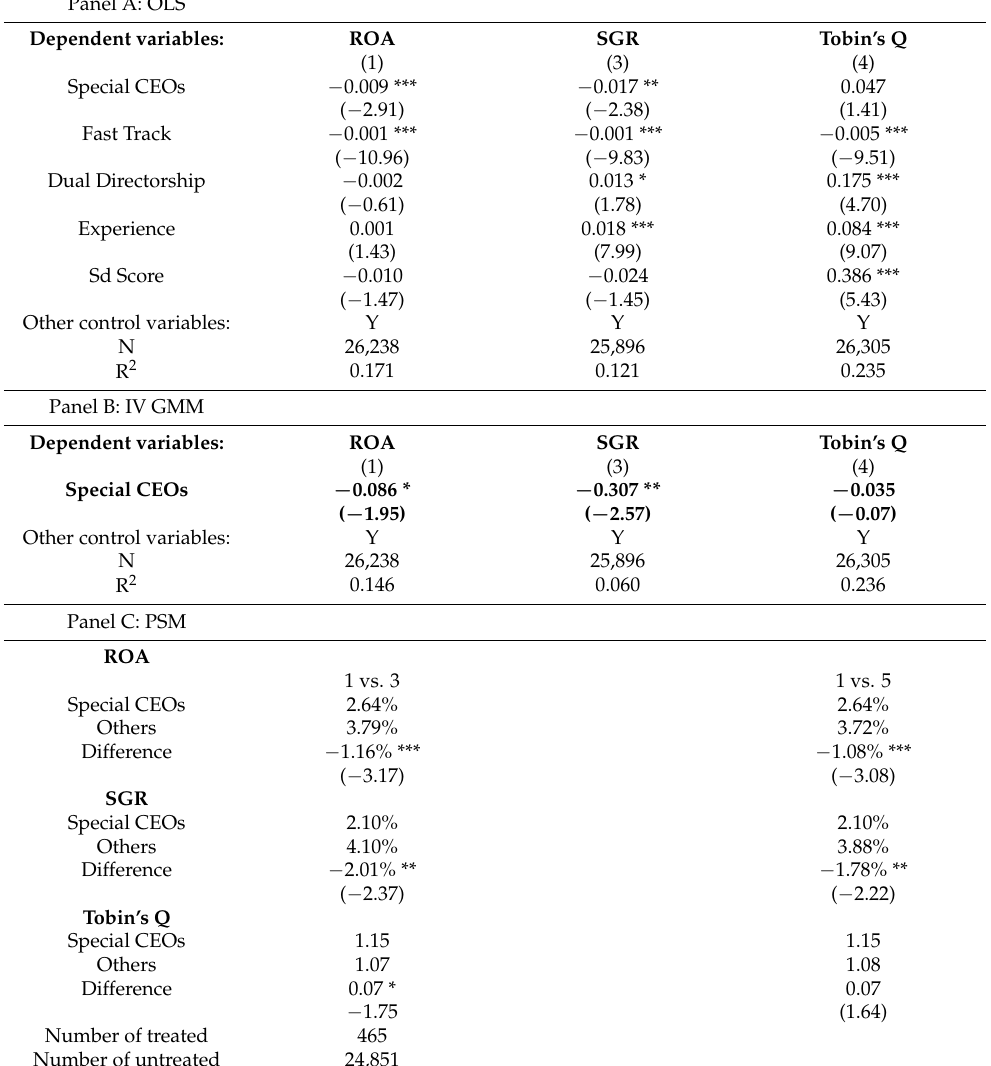
Table 7. Controlling for more CEO